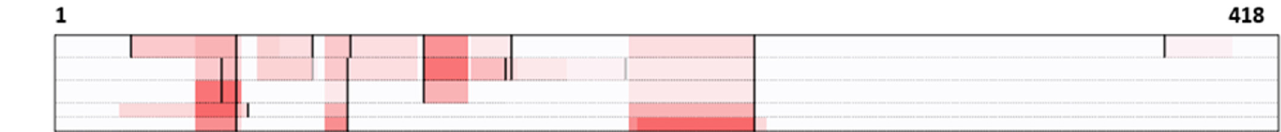
Figure 3. Immunohistochemistry of amyloid-producing ameloblastoma (APAB) in dogs and cats. ( A – C ) APAB; dog No. 3. Amyloid deposits were strongly positive to N-terminal region of amelo- blastin ( A ), weakly positive to odontogenic ameloblast-associated protein ( B ), and negative to ameloblastin middle region ( C ). ( D – F ) APAB; cat No. 2. Amyloid deposits were strongly positive to N-terminal region of ameloblastin ( D ), weakly positive to odontogenic ameloblast-associated protein ( E ), and negative to ameloblastin middle region ( F ). Scale bars: 400 µm. 4. Discussion In this study, mass-spectrometry-based proteomic analysis extracted ameloblastin as a prime candidate for precursor protein of APAB, and immunohistochemistry showed evidence for the existence of ameloblastin in amyloid deposits of both cats and dogs. Sev- eral immunohistochemistry-based studies in canines and felines have shown that amelo- blastin [17,26,28], sheathlin, and amelogenin [17,28] are present in amyloid deposits but are negative for antibodies to cytokeratins and vimentin [17]. The amyloid of APABs from a cat, dog, and Bengal tiger did not contain odontogenic ameloblast-associated protein- related peptides but rather an ameloblastin-like peptide; an N-terminal residue of amelo- blastin was detected from collected amyloid deposits of these APAB cases [29]. This study identified ameloblastin as a major component of amyloid deposits via mass-spectrometry- based semi-quantitative analysis using the Mascot algorithm, while sheathlin and